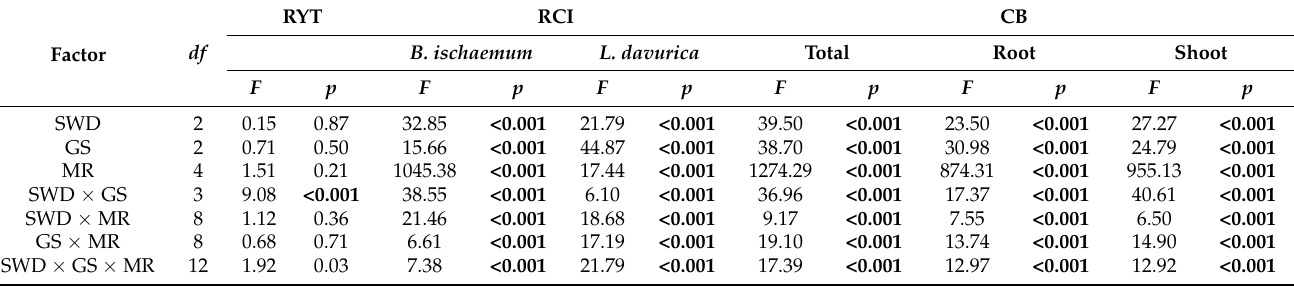
Table 3. Results of three-way ANOVA testing the effects of soil water decreasing (SWD), growth stage (GS), mixture ratio (MR), and their interactions on relative yield total (RYT) and relative competition intensity (RCI) calculated from biomass of both species, and competitive balance (CB) calculated from total biomass, shoot biomass and root biomass of B. ischaemum.